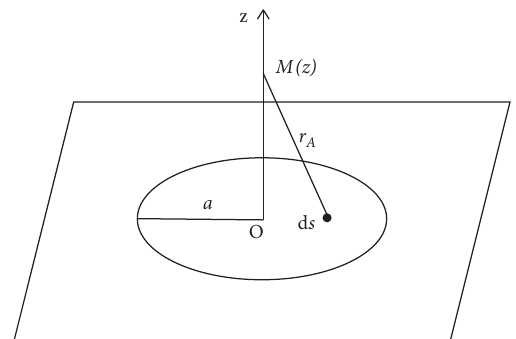
Figure 10: Coordinate frame for the circular knowledge radiator model.